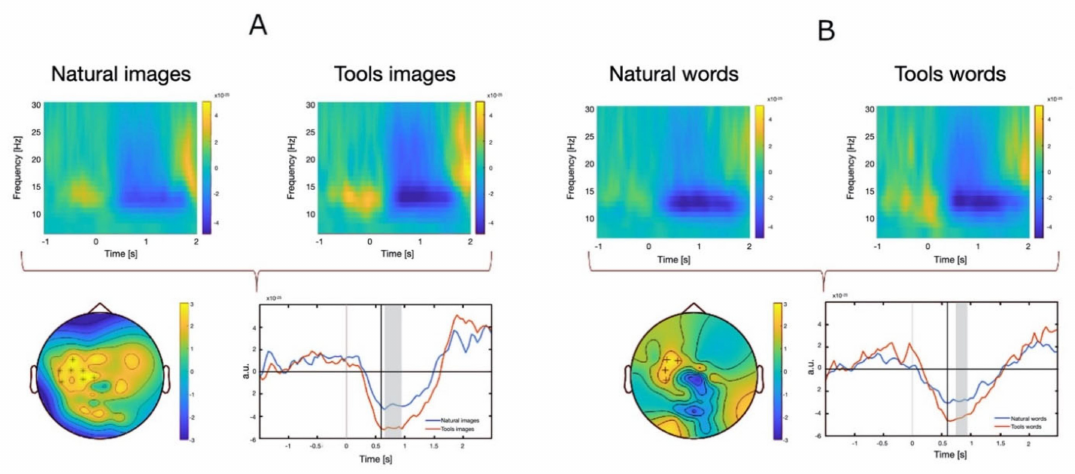
Figure 2. ( A ). Time-frequency representations (TFR) for each pair of stimulus type comparison (( A ): natural vs. tools images; ( B ): natural vs. tools nouns). Upper panel. Mean TFR values of the sensors in the contralateral motor area for the different stimuli. Note the beta pattern of desynchro- nization (reduction of power) and synchronization (increase of power) more evident in the case of tools stimuli. Lower panel. On the left, map of significant difference in beta band averaged over the time interval between 0.6 and 0.9 s for images and between 0.7 and 0.9 s for nouns, Asterisks indicate p < 0.01, plus indicate p < 0.05. On the right, time course of beta band power modification for each stimulus type. Shadowed area indicates the time range where the difference was significant ( p <